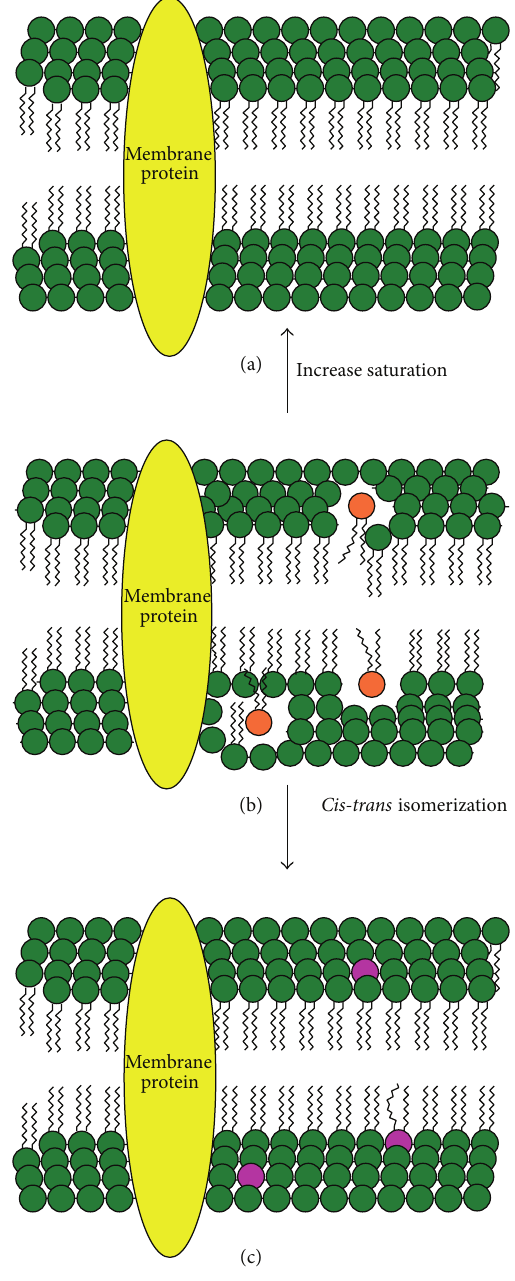
Figure 1: Two mechanisms increasing bacterial membrane saturation and decreasing membrane fluidity. The first one (direction from (b) to (a)) describes the increase of the synthesis of saturated fatty acids (green circles) instead of cis unsaturated fatty acids (orange circles); the second one (from (b) to (c)) shows the isomerization of cis unsaturated fatty acids into corresponding trans isomers (purple